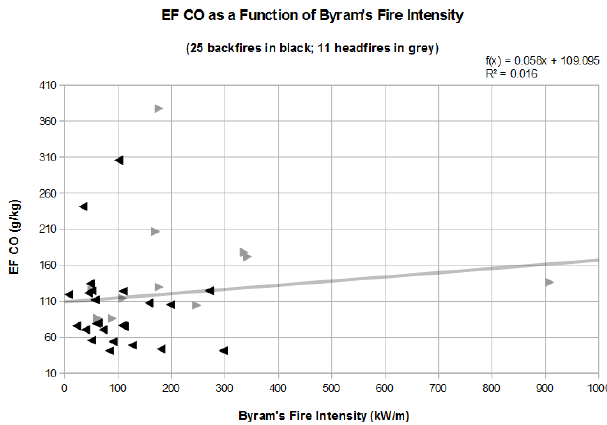
Figure 5. Carbon monoxide EF as a function of Byram’s fire inten- sity for all fires. Arrows indicate fire type (2014–2016,